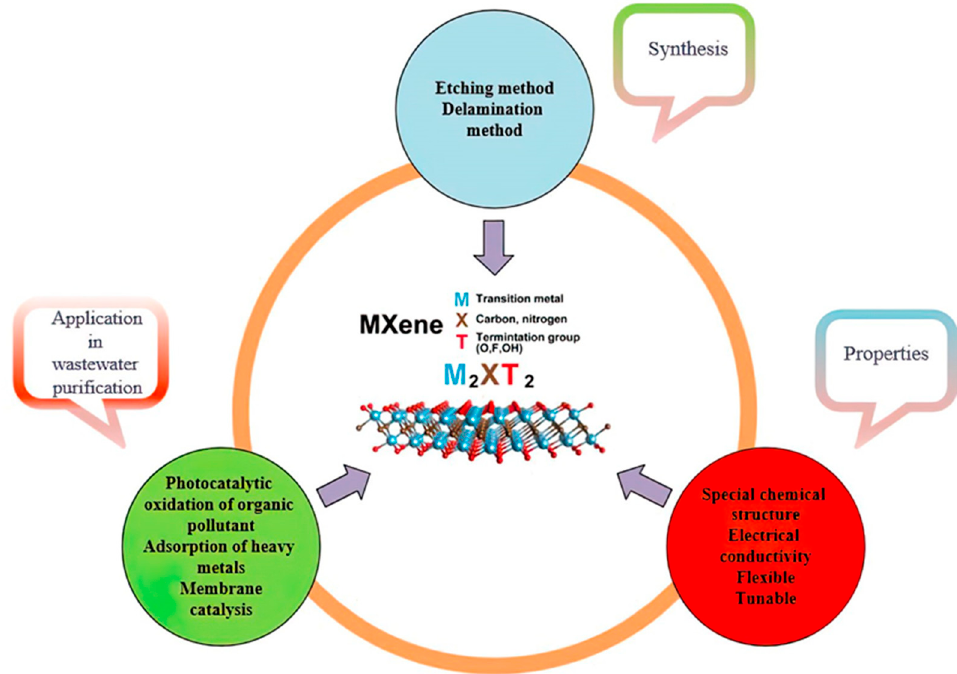
Figure 1. A description of MXene synthesis, features, and applications.